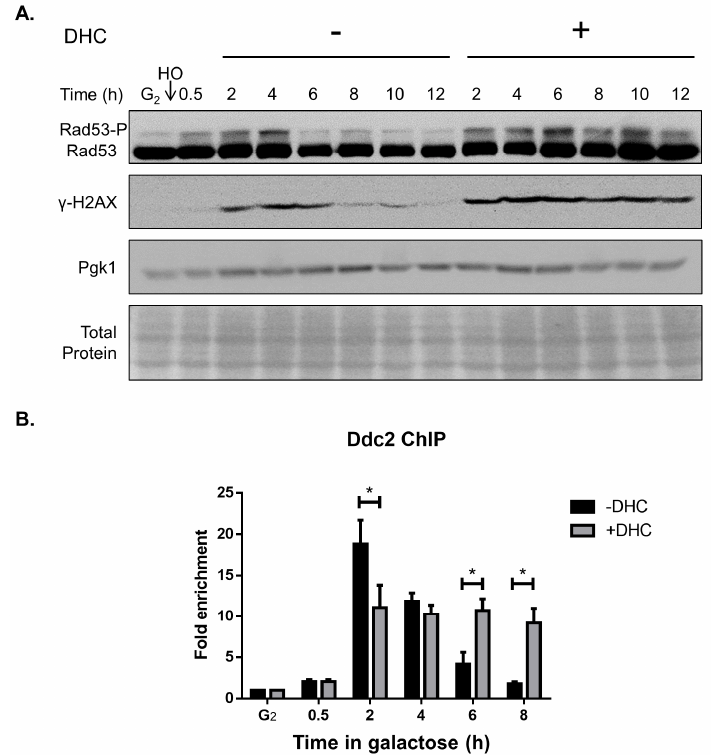
Figure 3. DHC influences the DNA damage checkpoint. ( A ) Wild-type cells (YMV045) were arrested at G2 with 15 µg/mL nocodazole, and HO endonuclease was induced by the addition of galactose to generate a DSB. After 30 min, the cultures were divided equally and treated with or without 5 mM DHC. Anti-Rad53 and anti-Y-H2A antibodies were used for the detection of protein expression by immunoblotting. Amido black staining of the total protein and Pgk1 protein levels, which served as the loading controls, was performed; ( B ) The recruitment of Ddc2 to flank the HO lesion in DDC2::MYC cells (RLY001) was analyzed by ChIP. The error bars represent the standard deviations from at least three independent experiments. Asterisks (*) indicate significant differences between DHC-treated and untreated cells (* p < 0.05).